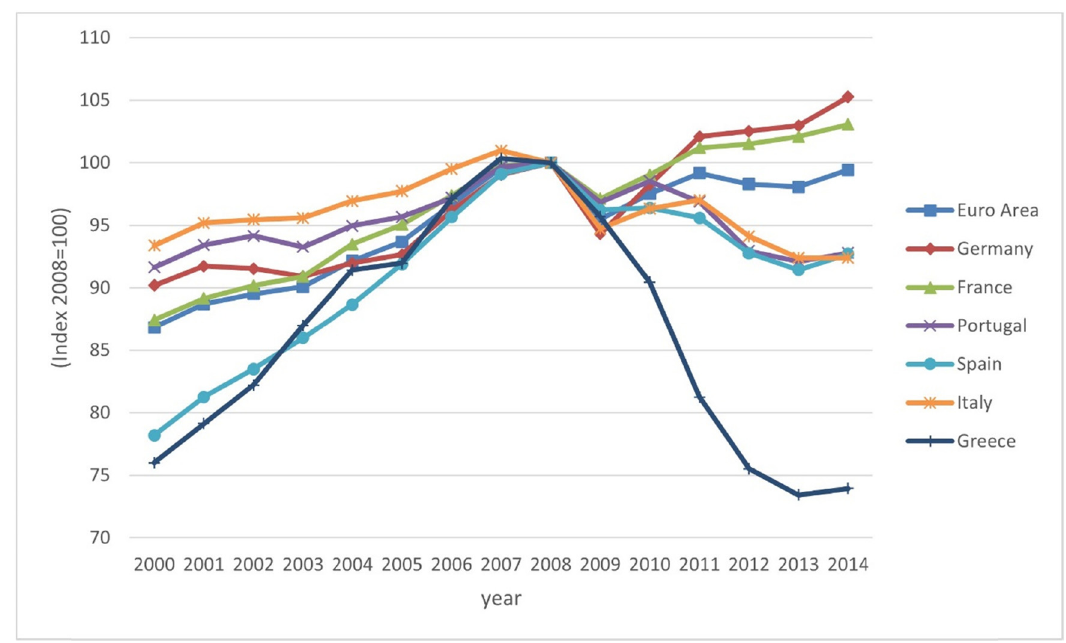
Figure 1: Evolution of the GDP. Source: Data from AMECO -